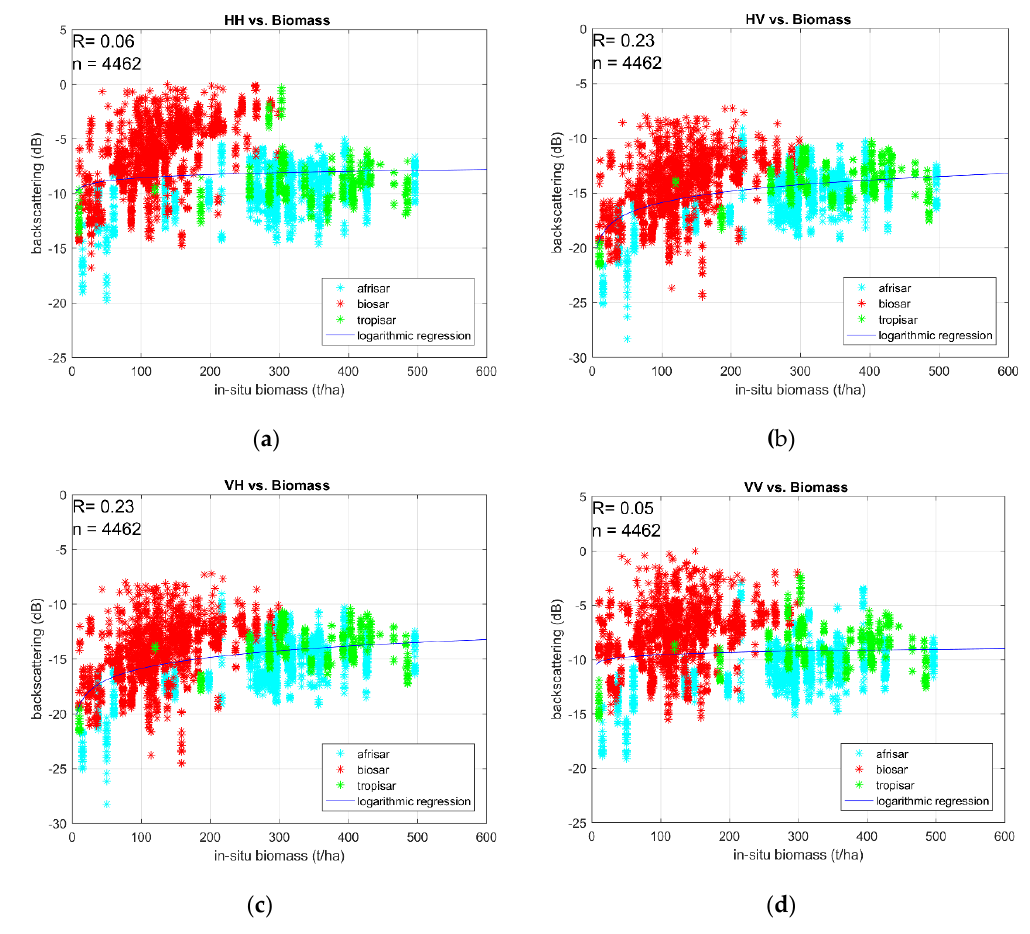
Figure 4. All data: σ° in ( a ) HH, ( b ) HV, ( c ) VH, and ( d ) VV vs. Biomass.